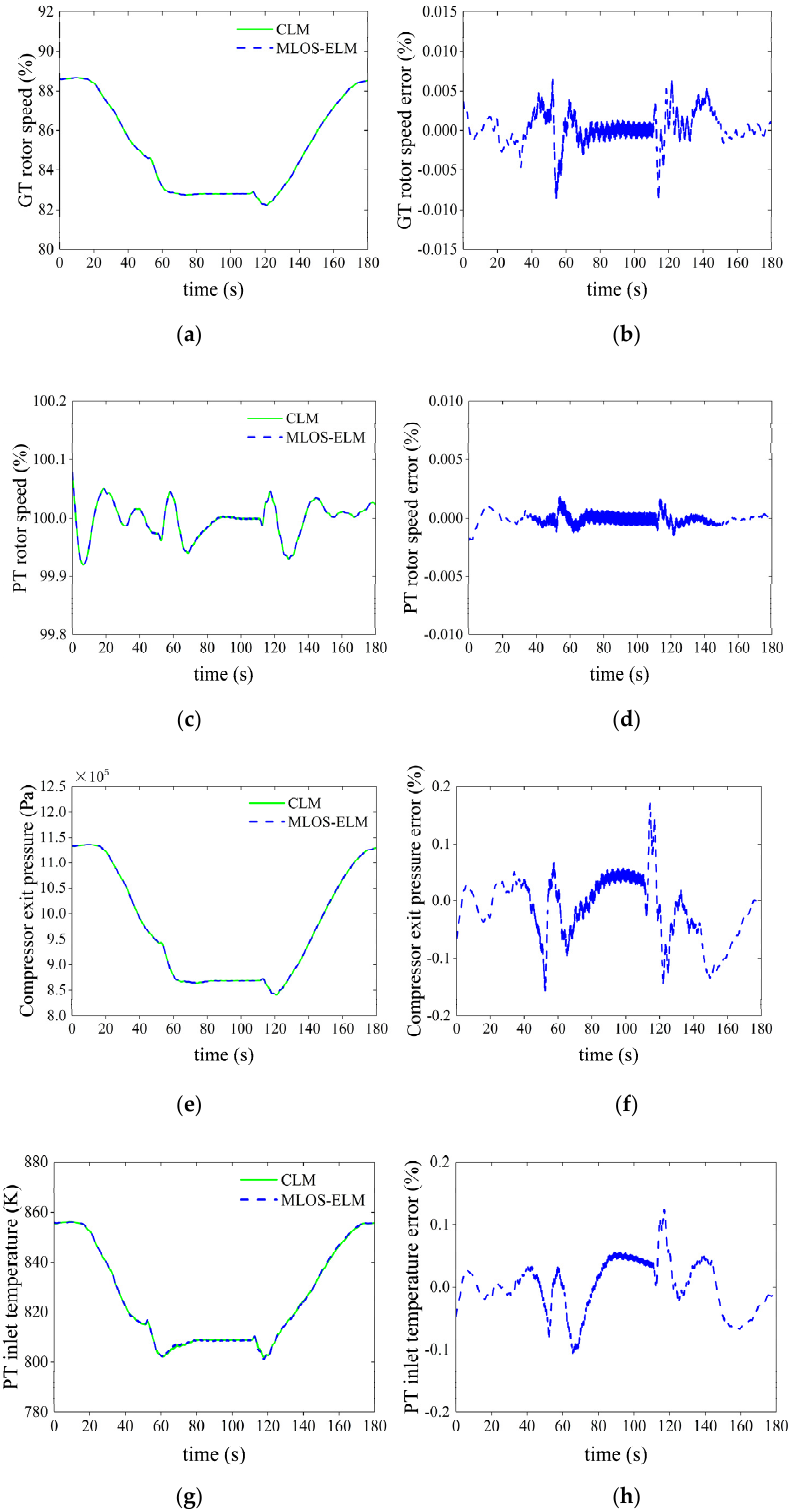
Figure 4. Output comparison of MLOS-ELM and CLM ( a ) Responses of GT rotor speed. ( b ) Relative error of GT rotor speed. ( c ) Responses of PT rotor speed. ( d ) Relative error of PT rotor speed. ( e ) Responses of compressor exit pressure. ( f ) Relative error of compressor exit pressure. ( g ) Responses of PT inlet temperature. ( h ) Relative error of PT inlet